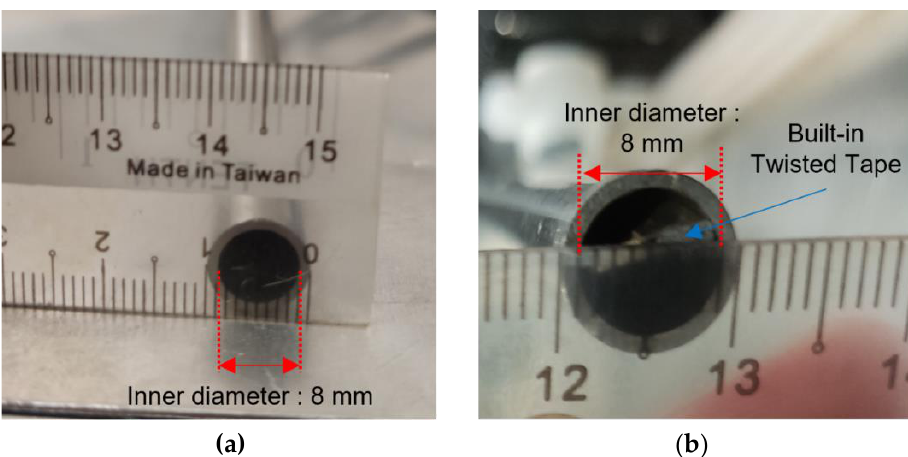
Figure 6. Photograph of experimental setup.